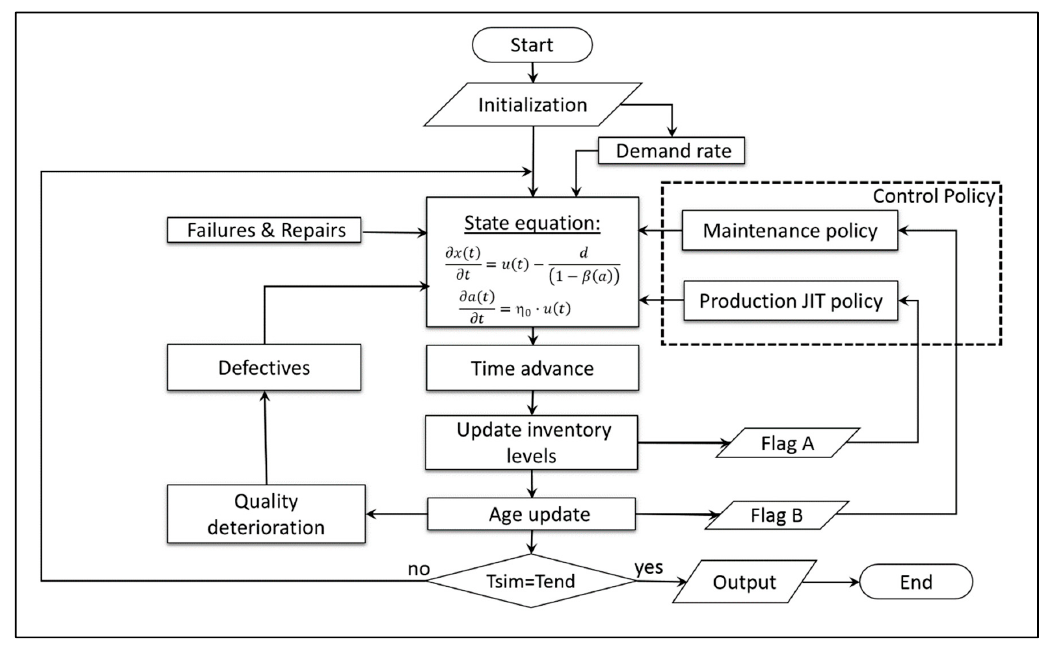
Figure 1. Block diagram of the simulation model.